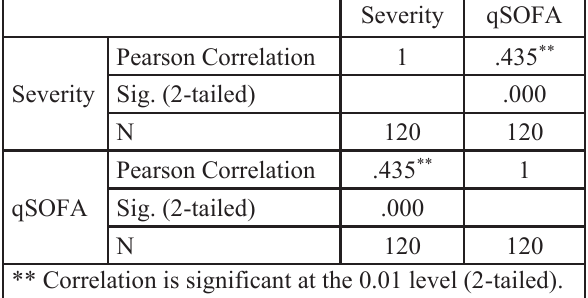
Table-2: Pearson Correlation of qSOFA with Severity of